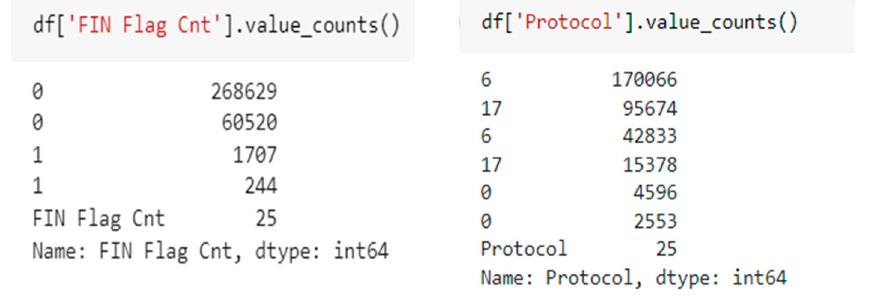
Figure 3. info() method.